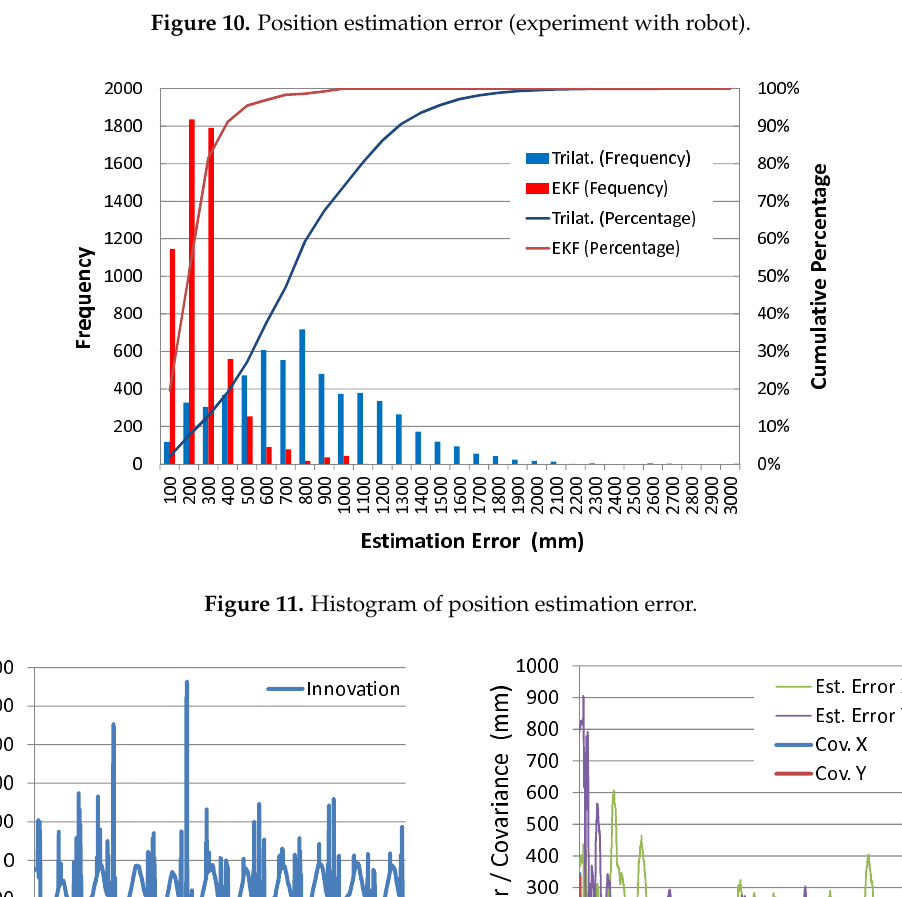
Figure 10. Position estimation error (experiment with robot).